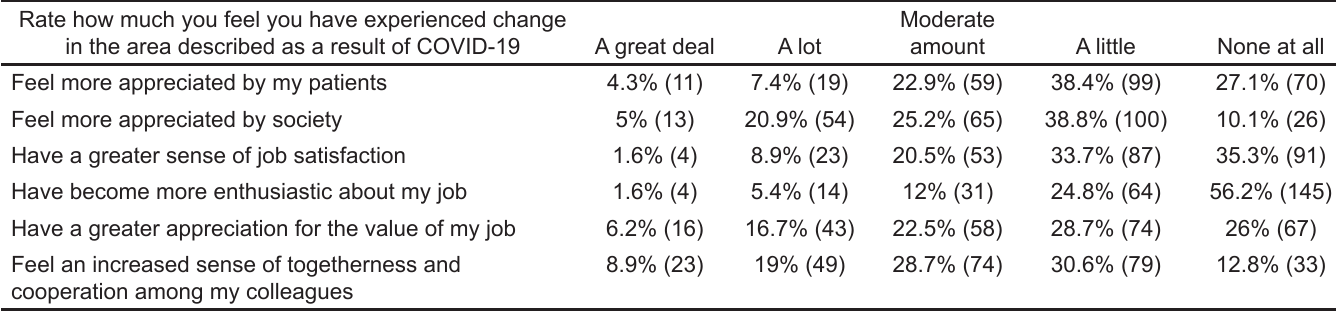
COVID-19 , coronavirus disease